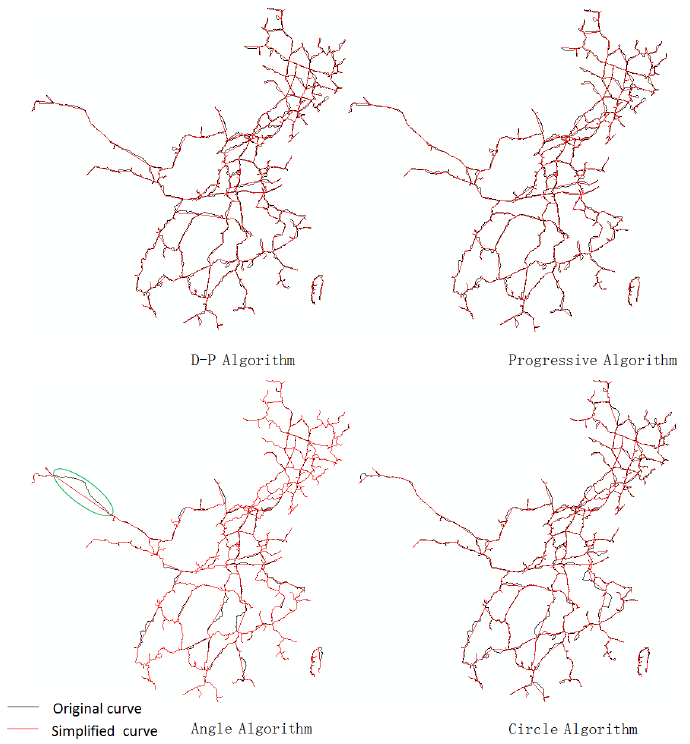
Figure 7. The standard deviation of average offset distance of the four simplification algorithms.